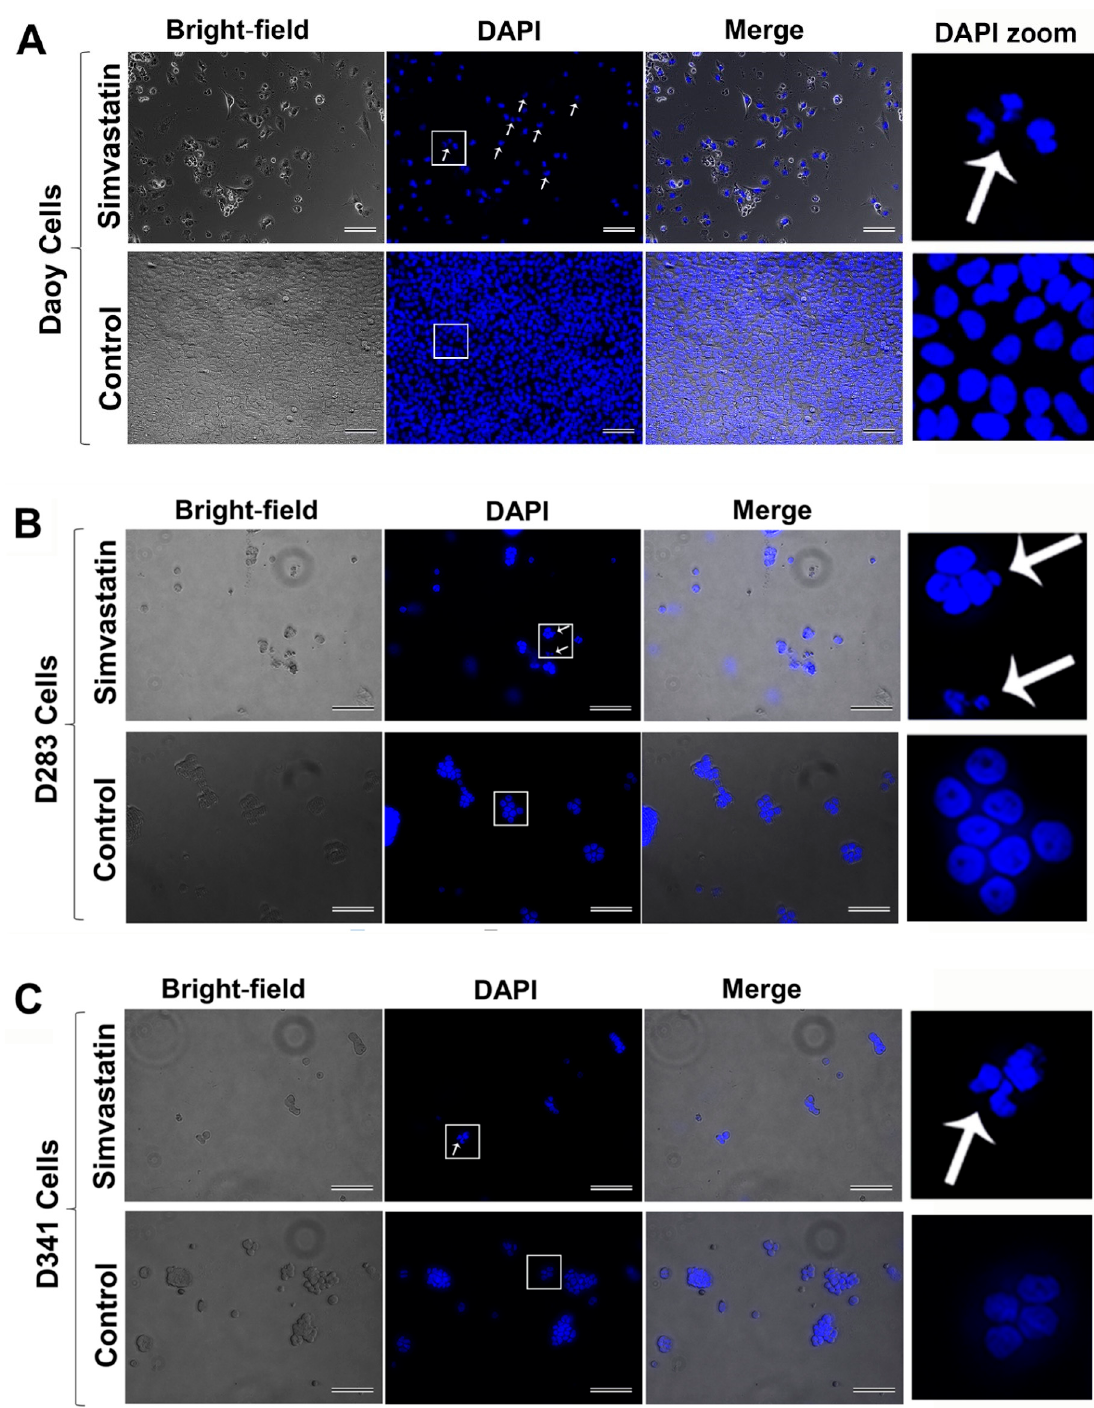
Figure 3. DAPI staining assay shows apoptosis in the nuclei of simvastatin-treated medulloblastoma cells. Daoy ( A ), D283 ( B ), and D341 cells ( C ) were cultured in 0.1% gelatin-coated plates and treated with 5 µ M simvastatin, along with control non-treated cells for 72 h. Subsequently, cells were fixed, washed, and stained with DAPI at a 1 µ g / mL final concentration. The simvastatin-treated cells showed condensed and fragmented nuclei (indicated by arrow). In the control non-treated cells, a normal morphology of nuclei was observed. Scale bar represents 50 µ